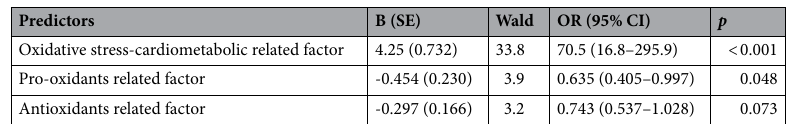
Table 5. Binary logistic regression analysis of predictors of NAFLD status. B-Beta; SE-Standard error; CI-Confidence interval; OR-Odds ratio.